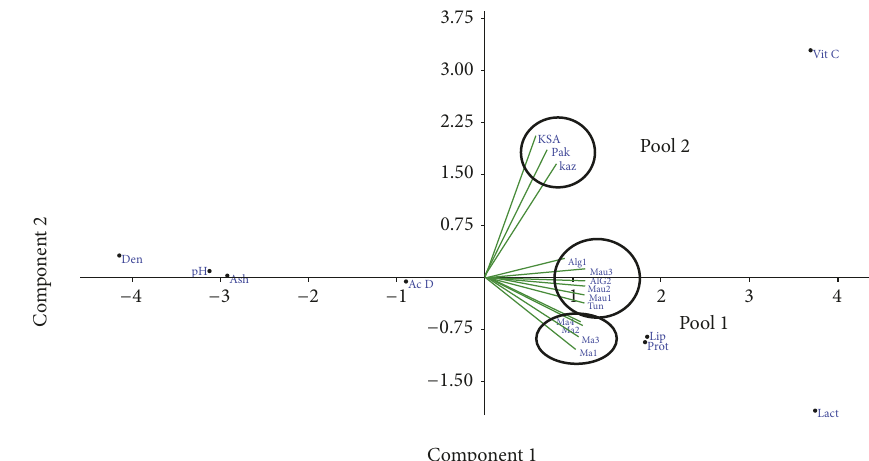
Figure 2: PCA representation of dromedary milk types and their physicochemical and biochemical characteristics represented on two